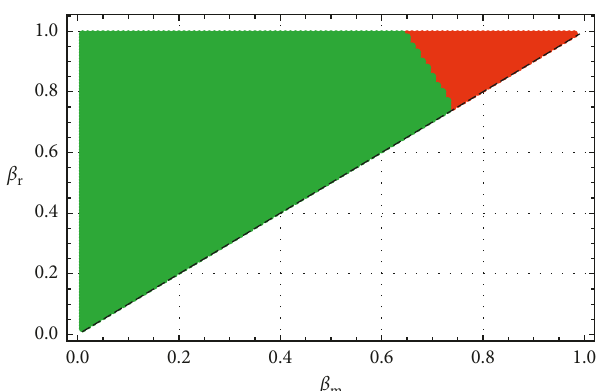
Figure 9: Comparison of steady-state profits with β